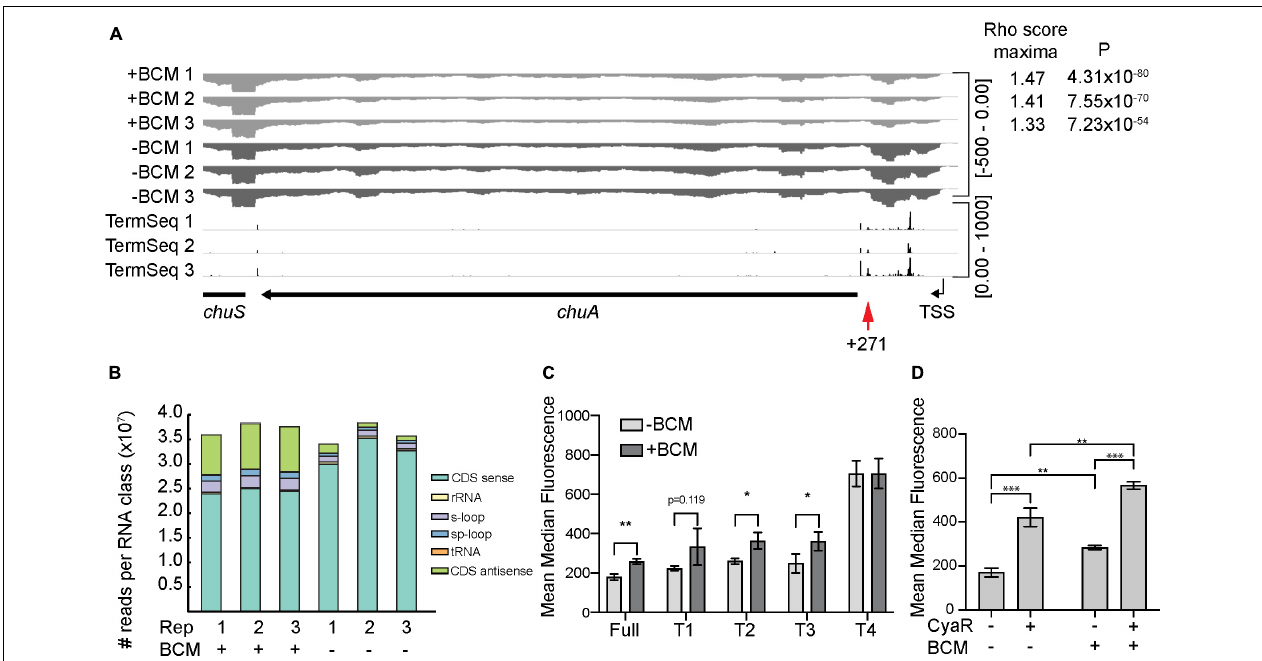
FIGURE 5 | The chuA 5 (cid:48) UTR is subject to termination by Rho. (A) RNA-seq coverage of chuA in EHEC O157:H7 strain Sakai treated and untreated with bicyclomycin. Rho scores for each replicate is shown. TSS is derived from differential RNA-seq data and is indicated by an arrow. Term-seq reads indicating chuA 3 (cid:48) ends are also included. (B) Classification and number of reads per RNA class upon treatment of EHEC O157:H7 strain Sakai with bicyclomycin. (C) Fluorescence measurements of full-length and truncated chuA- sfGFP fusions in the presence and absence of induction with bicyclomycin. (D) Fluorescence measurements of chuA- sfGFP translational fusion in the presence and absence of CyaR overexpression plasmid and treatment with bicyclomycin. Measurements are the mean median fluorescence intensity of three biological replicates (*** p < 0.001, ** p < 0.01, * p < 0.05).